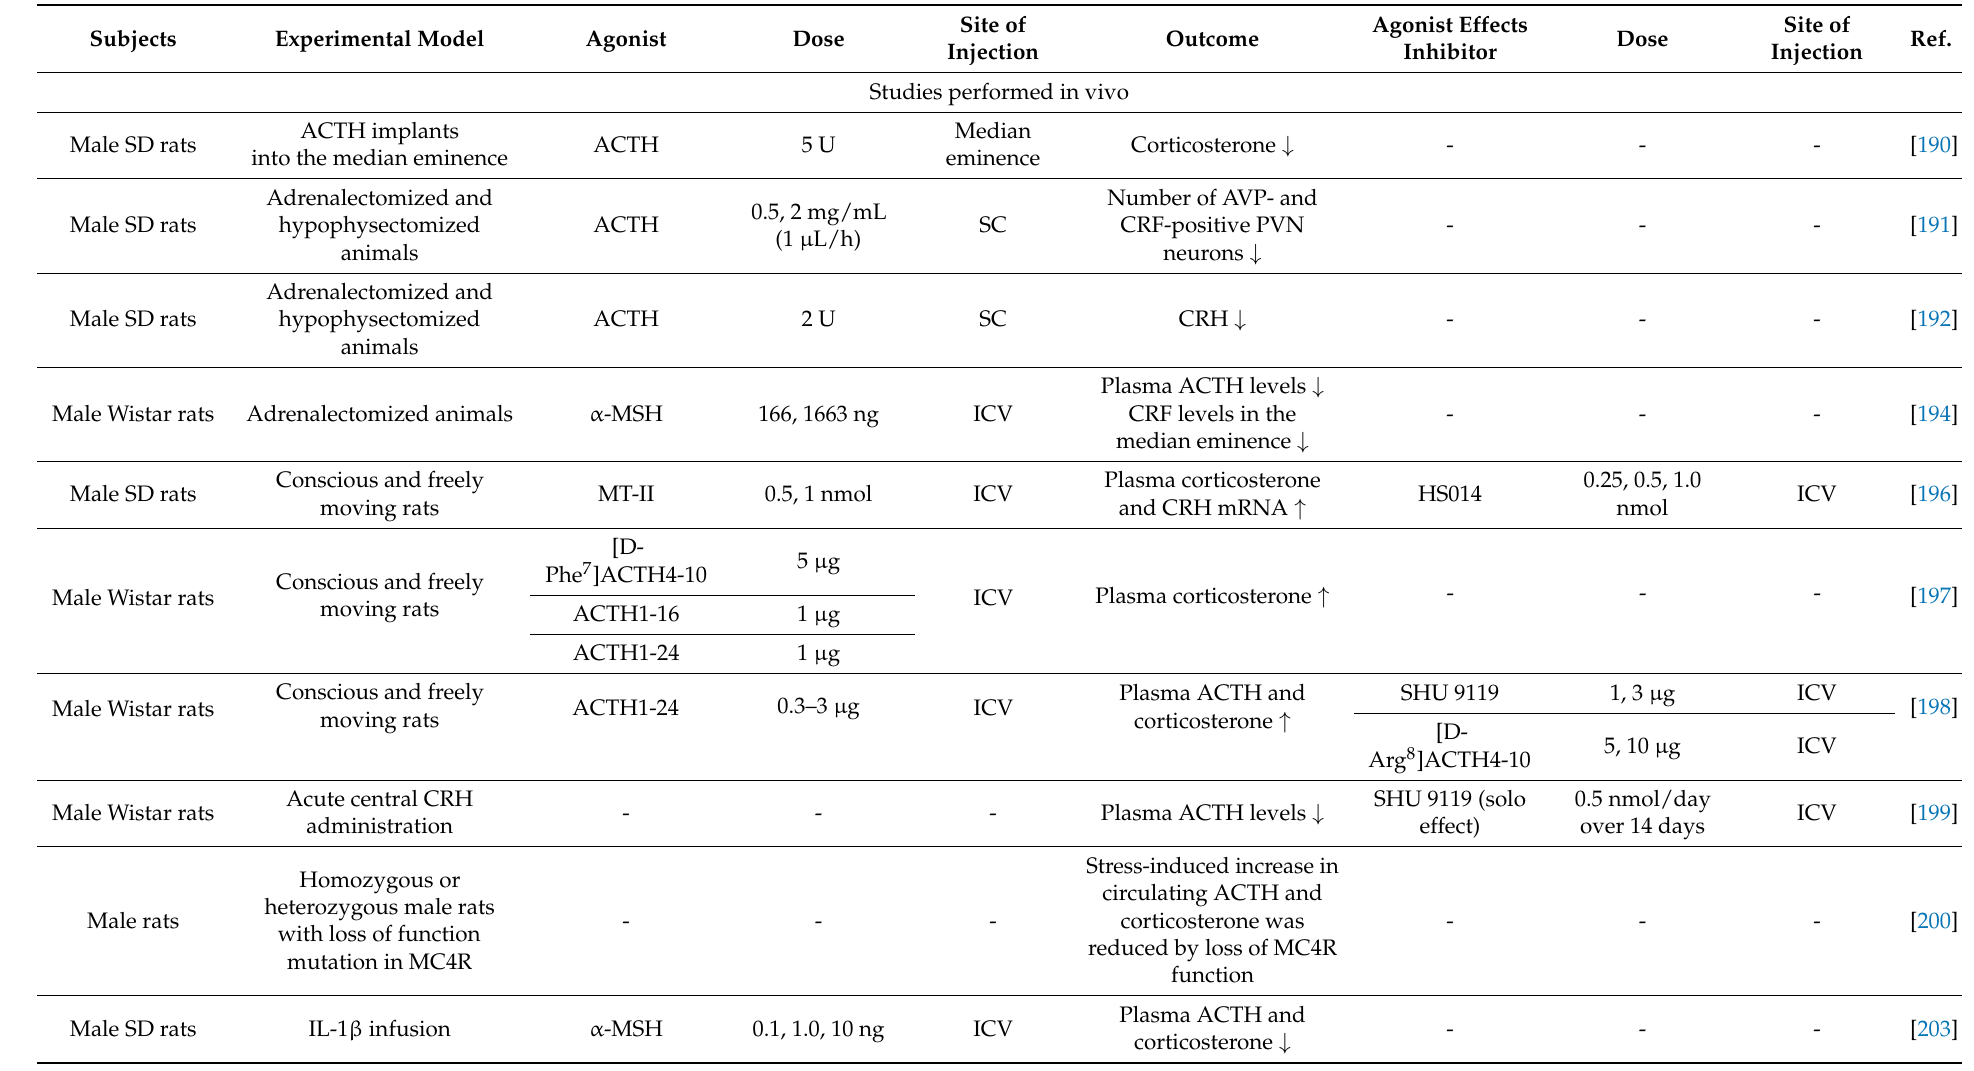
Table 4. A summary of the effects of melanocortin agonists on HPAA